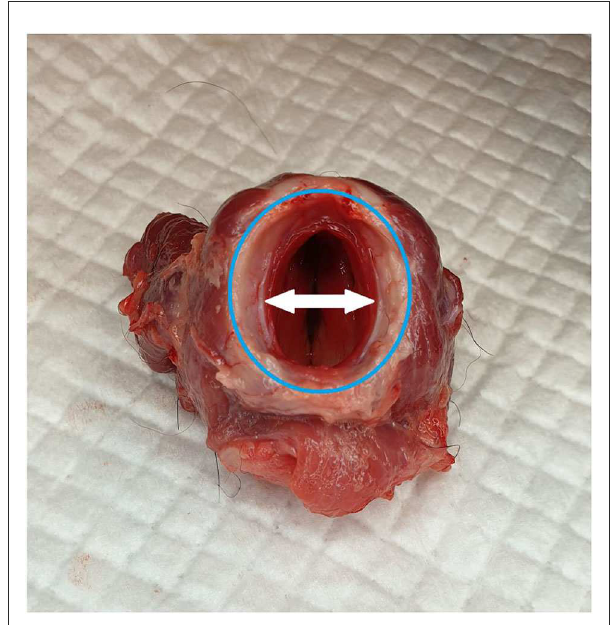
FIGURE1 Caudal view of the larynx, with the ventral aspect toward the top of the image. The shape of the caudal cricoid is more circular when compared to the ovoid trachea (highlighted by the blue ring). The internal diameter at the narrowest point of the cricoid ring is smaller laterally, which is opposite to the trachea (white